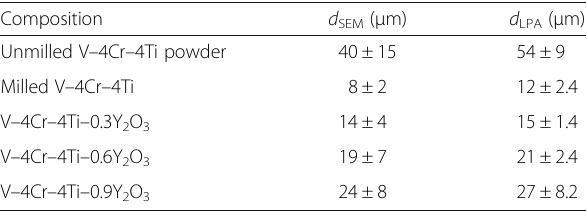
Table 2 Comparison of particle size outcomes obtained from the SEM and laser particle analysis Composition d SEM ( μ m) d LPA ( μ m) 40 ± 15 54 ± 9